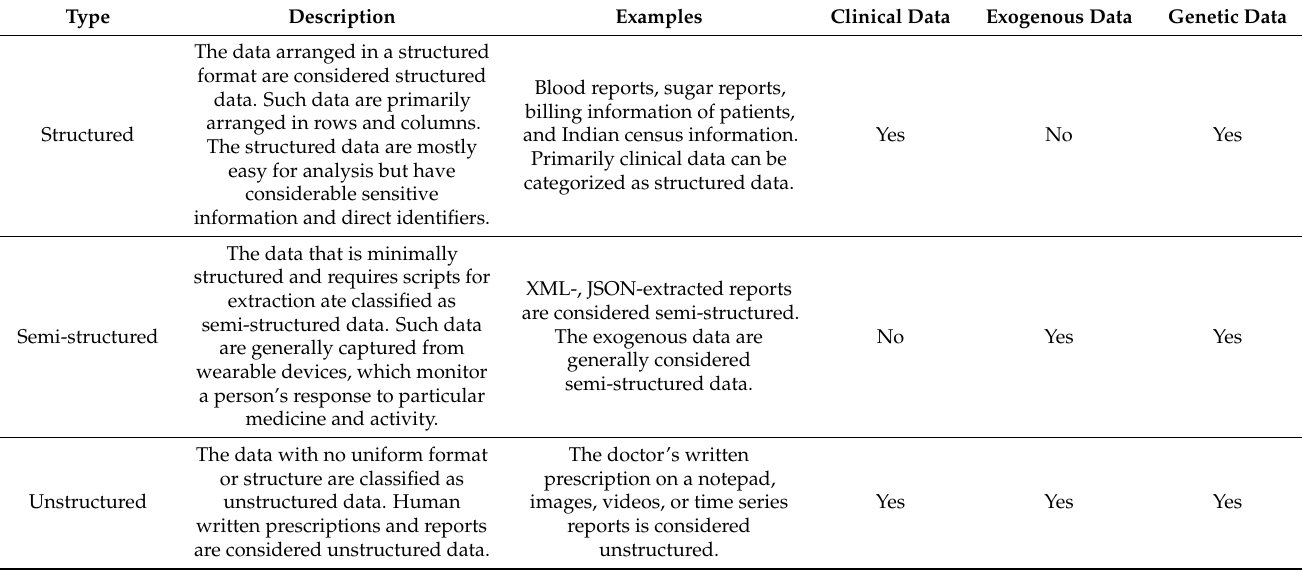
Table 5. Type of healthcare